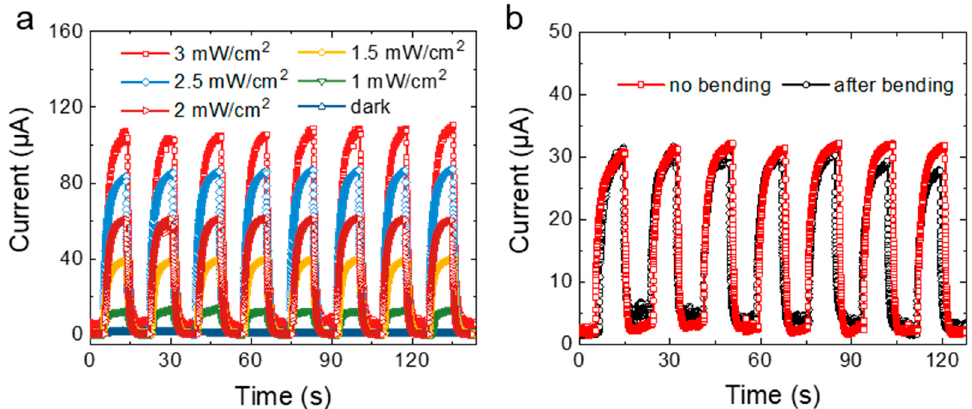
Figure 6. ( a ) Photocurrent of the NPG/ZnONWs-based photodetector under different incident light intensity, ( b ) photocurrent of the NPG/ZnONWs-based photodetector before and after 1000-times bending.